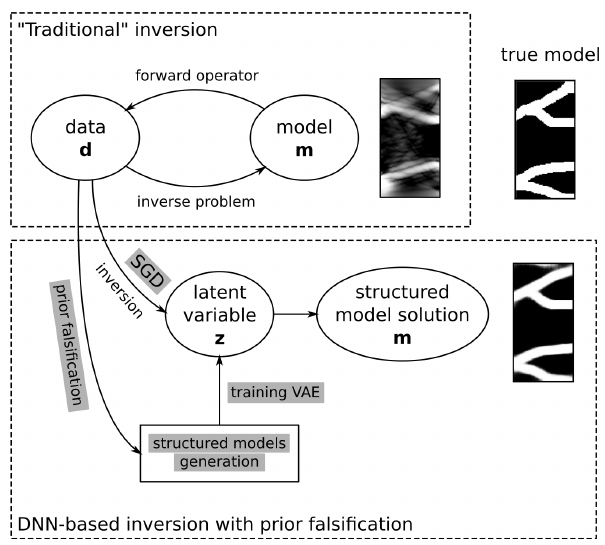
Figure 6. Adapted deep neural network-based (DNN) inversion scheme using a variational autoencoder (VAE) to represent complex geological structure in a latent space represented by sparse variable in which a stochastic gradient descent (SGD) can be applied to con- verge towards a more geologically realistic solution, modified from Lopez-Alvis et al.